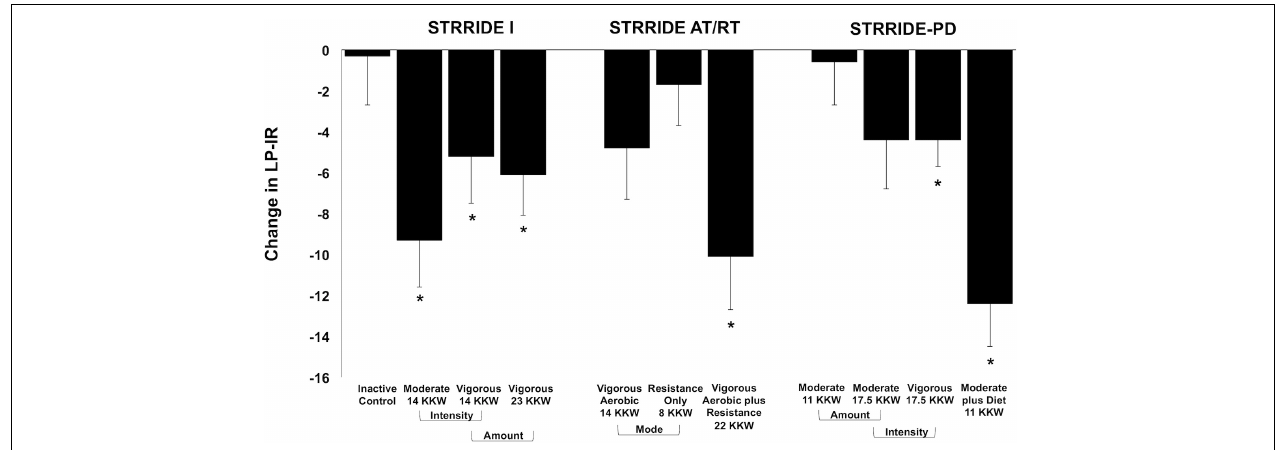
FIGURE 1 | Change in Lipoprotein Insulin Resistance Index (LP-IR) following intervention across all groups from STRRIDE I, STRRIDE AT/RT, and STRRIDE-PD. Moderate and vigorous refer to prescribed aerobic exercise intensity. Prescribed amount of exercise represented by kcal/kg of body weight/week (KKW). *Denotes significant within-group change following